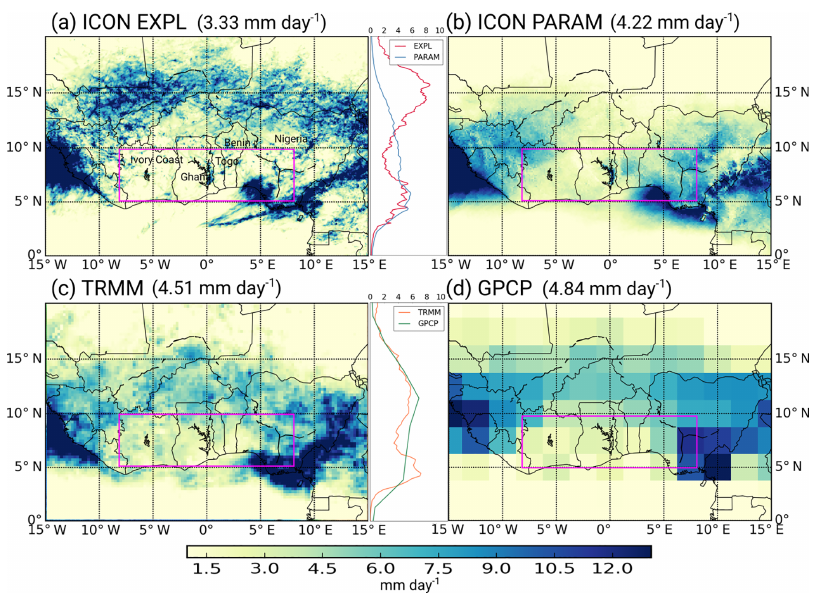
Figure 2. Mean daily rainfall for July 2006 over the larger West African domain for (a) ICON EXPL and (b) ICON PARAM as well as the observational datasets (c) TRMM and (d) GPCP with averages over the DACCIWA box (marked with pink square) on top of each panel. The two small graphs between the panels contain the rainfall dependent on latitude averaged over 8 ◦ W–8 ◦